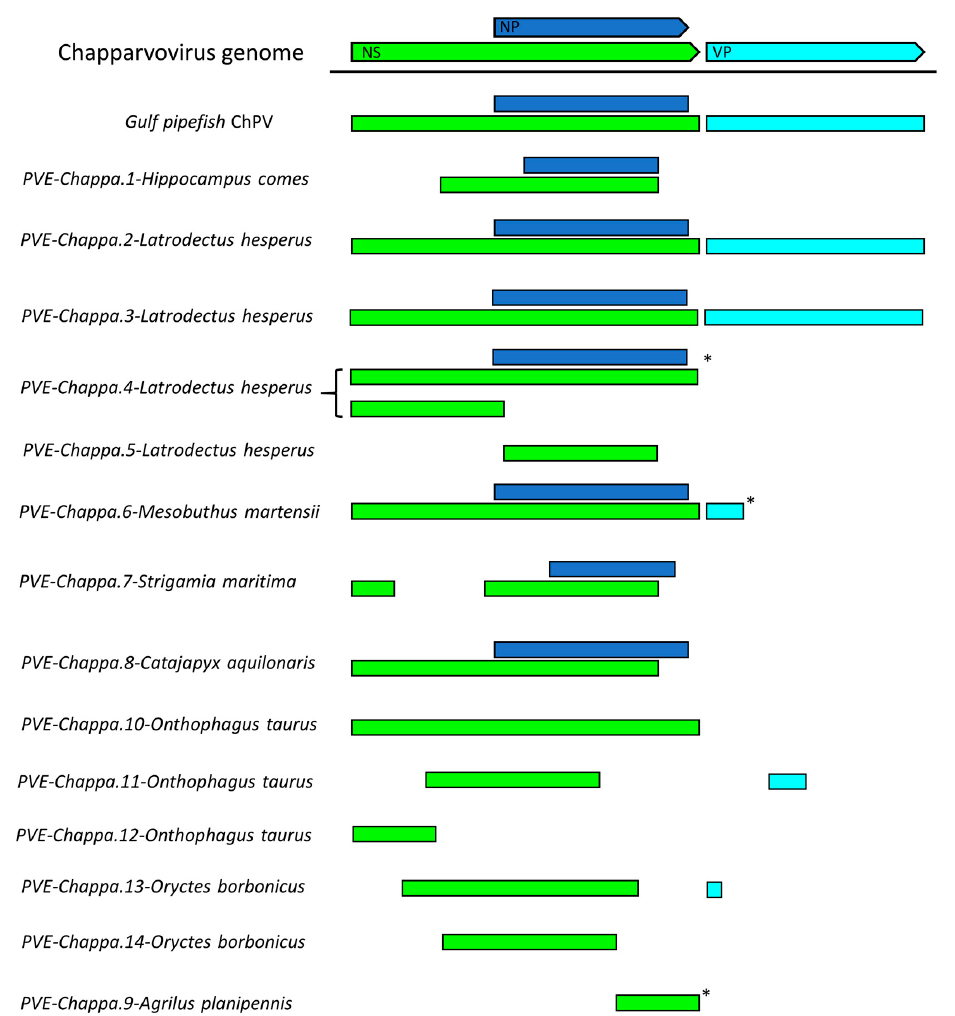
Figure 2. Basic gene content of newly identified chapparvoviruses (ChPVs) and ChPV-derived endogenous parvoviral element (EPV) sequences, shown in relation to a representative ChPV genome (mouse kidney parvovirus). Asterisks indicate contigs that were truncated within the virus-derived portion of the sequence. Abbreviations: non-structural protein (NS); capsid protein (VP); nucleoprotein (NP).